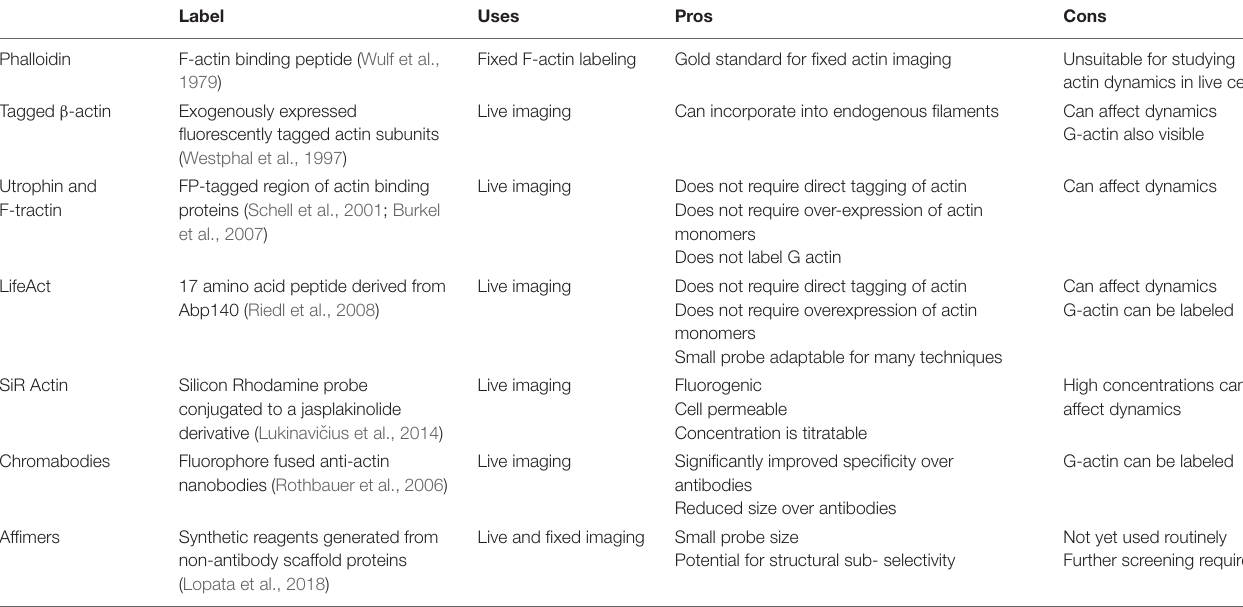
TABLE 1 | Summary of the advantages and disadvantages of different actin labeling